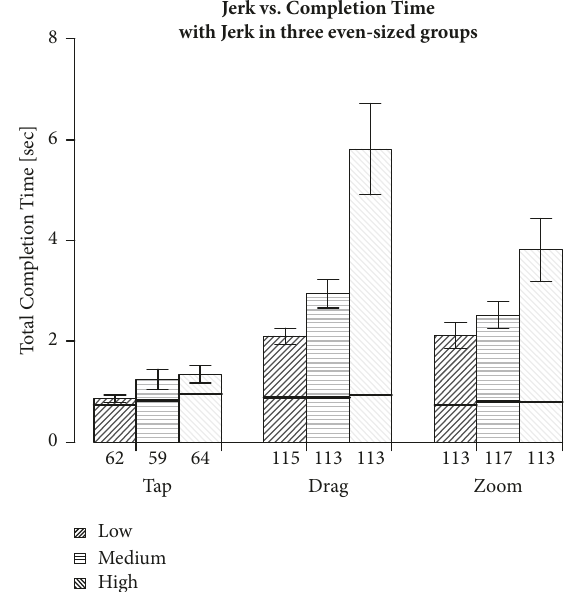
Figure 12: Completion time for the three task types depending on RMS of jerk intensity. The number of samples is given below the histograms.Horizontalbarsdenotetheaveragetimetofirstreaction.